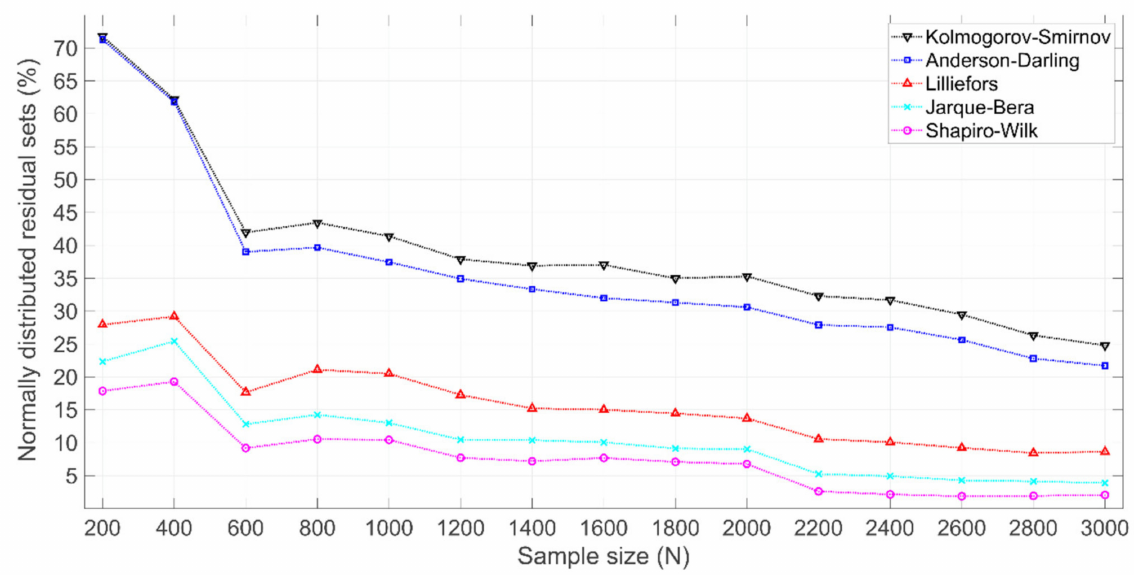
Figure 12. Percentage of normally distributed residual sets based on five hypothesis tests. Results highlight the adaptation performance of the tests on different datasets as a part of the system identification procedure. Low percentage indicates poor applicability in